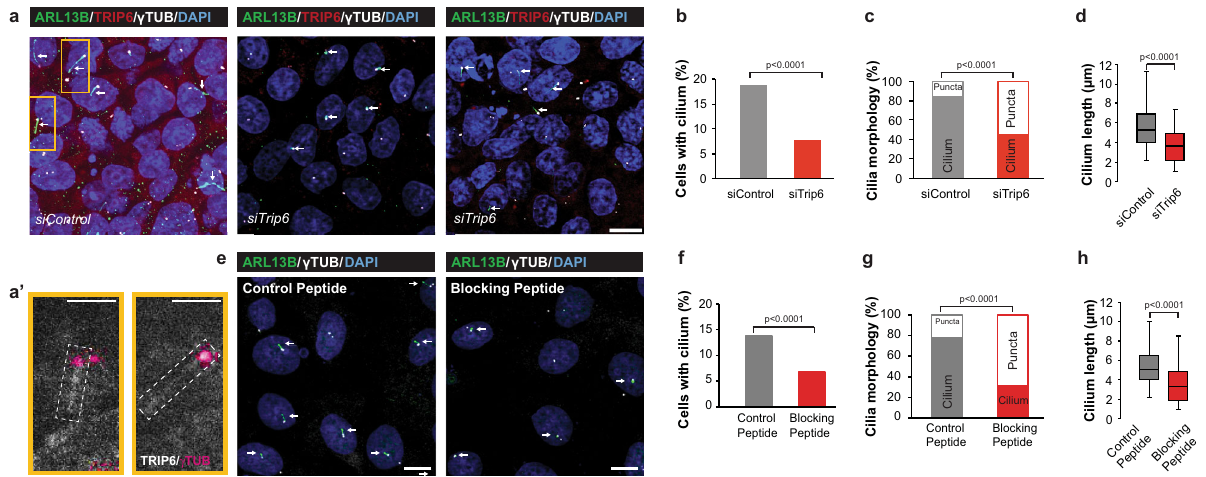
Fig. 8 Downregulation of trip6 by siRNA or blocking of TRIP6 dimerization, in the choroid plexus-derived cell line Z310, impairs cilium elongation or ciliogenesis. Z310 cells, transfected with the indicated siRNAs (siTrip6 or siControl) ( a ) or peptides (dimerization blocking or control) ( e ), were serum- starved to induce primary cilium formation (see “ Methods ” section for detailed description). The cells were analysed by immuno fl uorescence microscopy to visualize basal bodies (labeled by anti- γ -tubulin antibody) and the primary cilium (anti-ARL13B), and were counterstained with anti-TRIP6 and DAPI ( a ’ shows magni fi ed cilia from panel a ). Both inhibitory treatments signi fi cantly impaired primary cilium formation ( b , f ; analysed by two-tailed Fisher ’ s exact test) or — in those cells carrying cilia-like structures — cilium morphology ( c , g ; two-tailed Fisher ’ s exact test) and length ( d, h ; two-tailed Student ’ s t -test). Both phenotypes were adversely and signi fi cantly affected. The box plots ( d , h ) indicate the median (middle line), the interquartile range (IQR) from 1st to the 3rd quartile (box), and the upper edge (Q1 + 1.5*IQR) to lower edge (Q1 − 1.5*IQR) (whiskers). In the morphological assessment, “ puncta ” indicate basal bodies without associated axoneme. For detailed description of quanti fi cation and statistics, see “ Methods ” section. Source data are provided as a Source Data fi le. Additional analysis of the RNAi experiments is presented in Supplementary Fig. 5. Scale bars: 10 μ m (a, a',